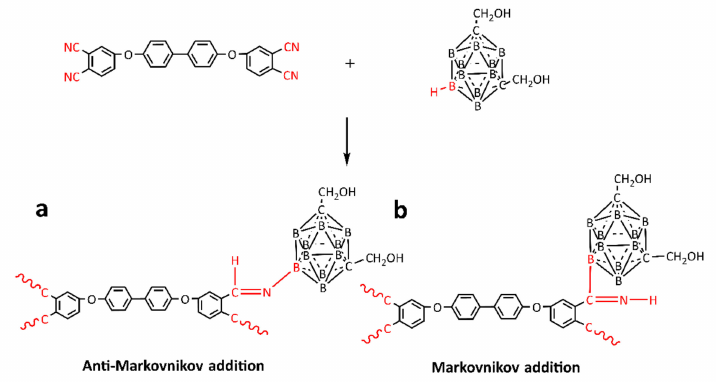
Figure 6. UV-Vis spectrum of BPh-Q thermosets. The UV-Vis reflectance spectrum is analyzed from 2000 to 200